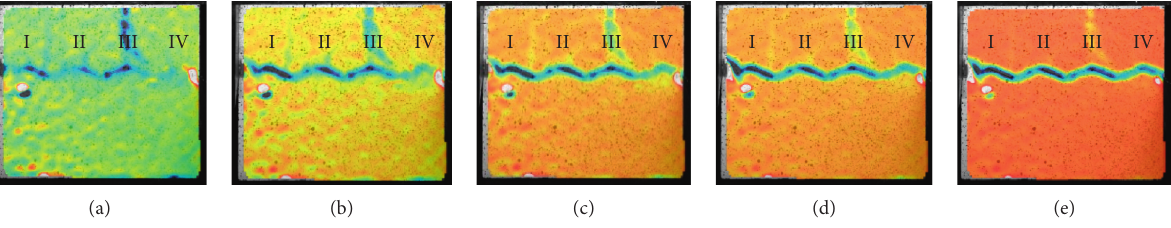
Figure 12: Typical development process of shear failure of jointed specimens (B-5).